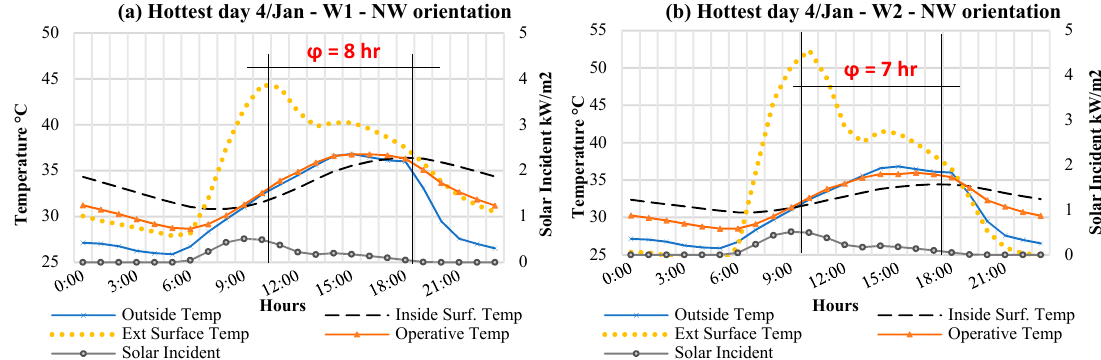
Figure 11. Surface temperatures for the wall with NW orientation in the original state W1 ( a ) and the solution W2 ( b ).